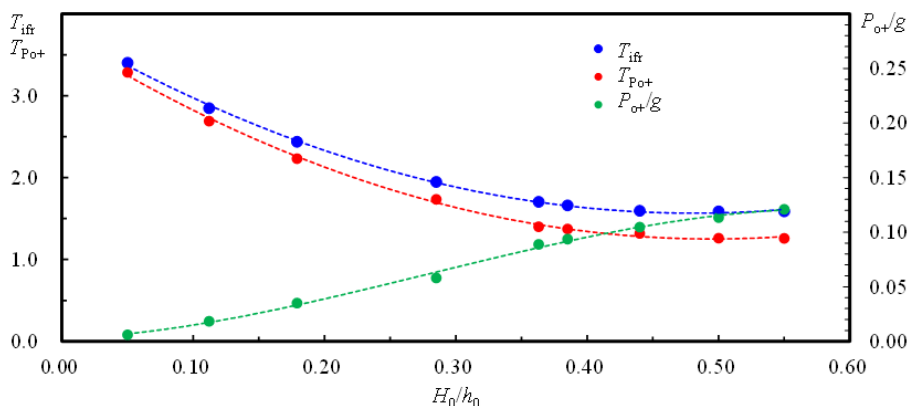
Figure 19. Variation trends of the non-dimensional times for occurrence of flow reversal and maximum adverse pressure gradient, and of the values of maximum adverse pressure gradient for H 0 / h 0 = 0.050–0.550.